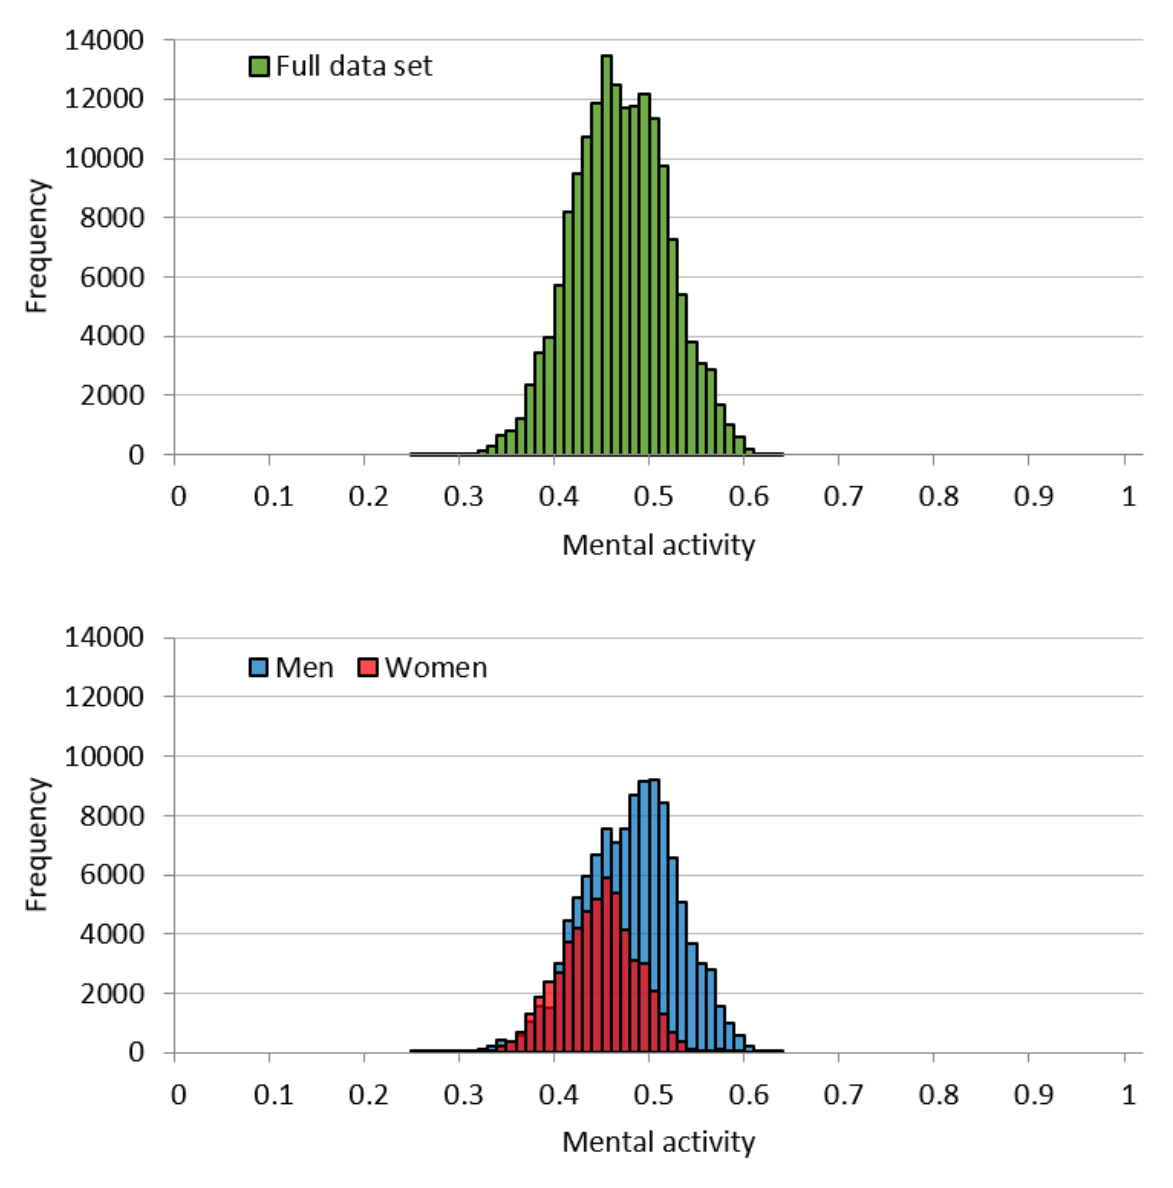
Figure 4. Call dataset mental activity distribution for the full set and by